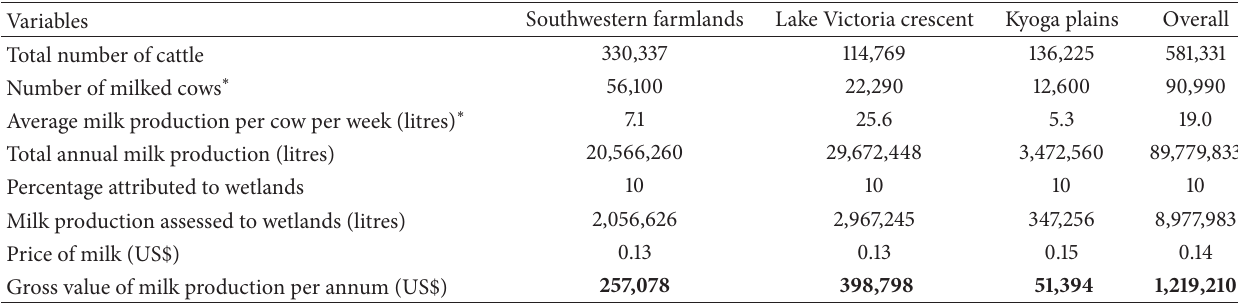
Table 8: Gross monetary value addition from wetlands through milk production in Uganda.